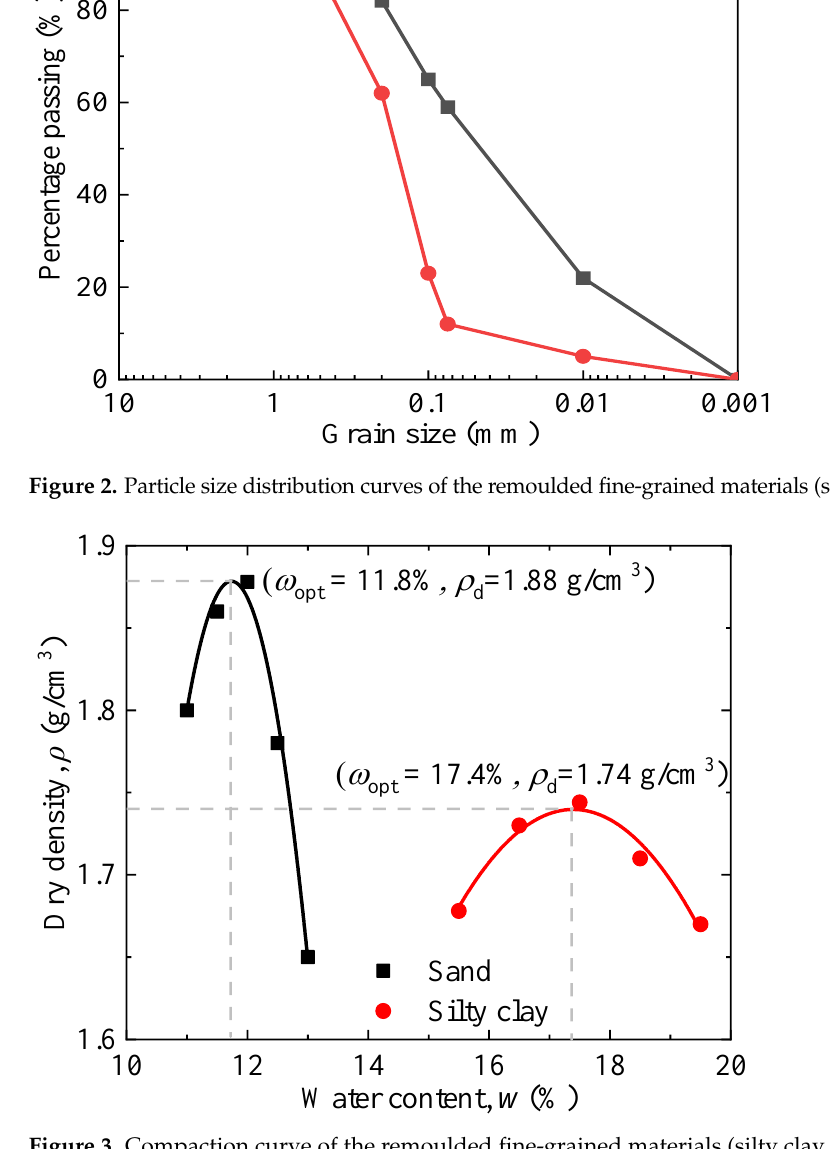
Figure 3. Compaction curve of the remoulded fine-grained materials (silty clay and sand) used in this study.